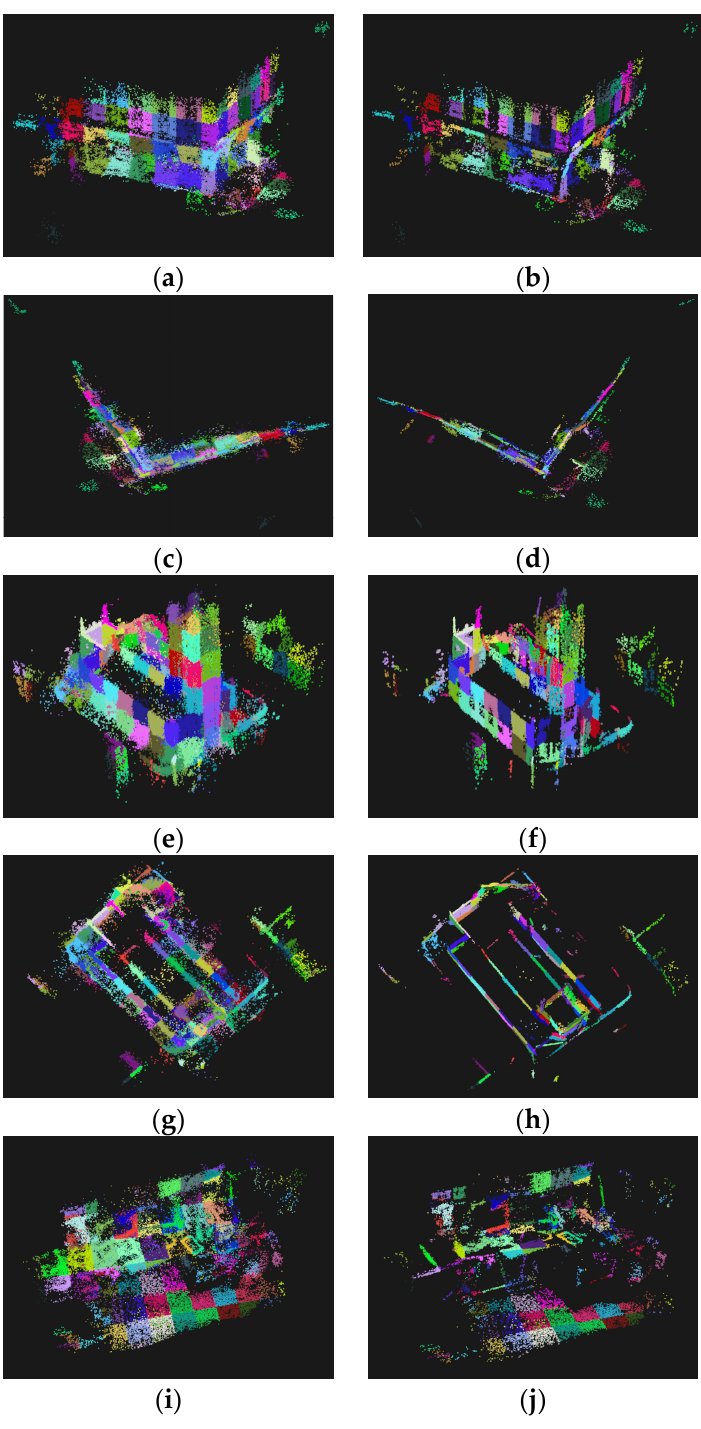
Figure 2. ( a ) Voxel-based representation of the Shop Façade scene. ( b ) Inlier 3D point set for the Shop Façade scene after random sample consensus (RANSAC)-based plane fitting. ( c , d ) Top views of ( a , b ), respectively. ( e ) Voxel-based representation of St Mary’s Church scene. ( f ) Inlier 3D point set for St. Mary’s Church scene. ( g , h ) Top views of ( e , f ), respectively. ( i ) Voxel-based representation of the Heads scene. ( j ) Inlier 3D point set for the Heads